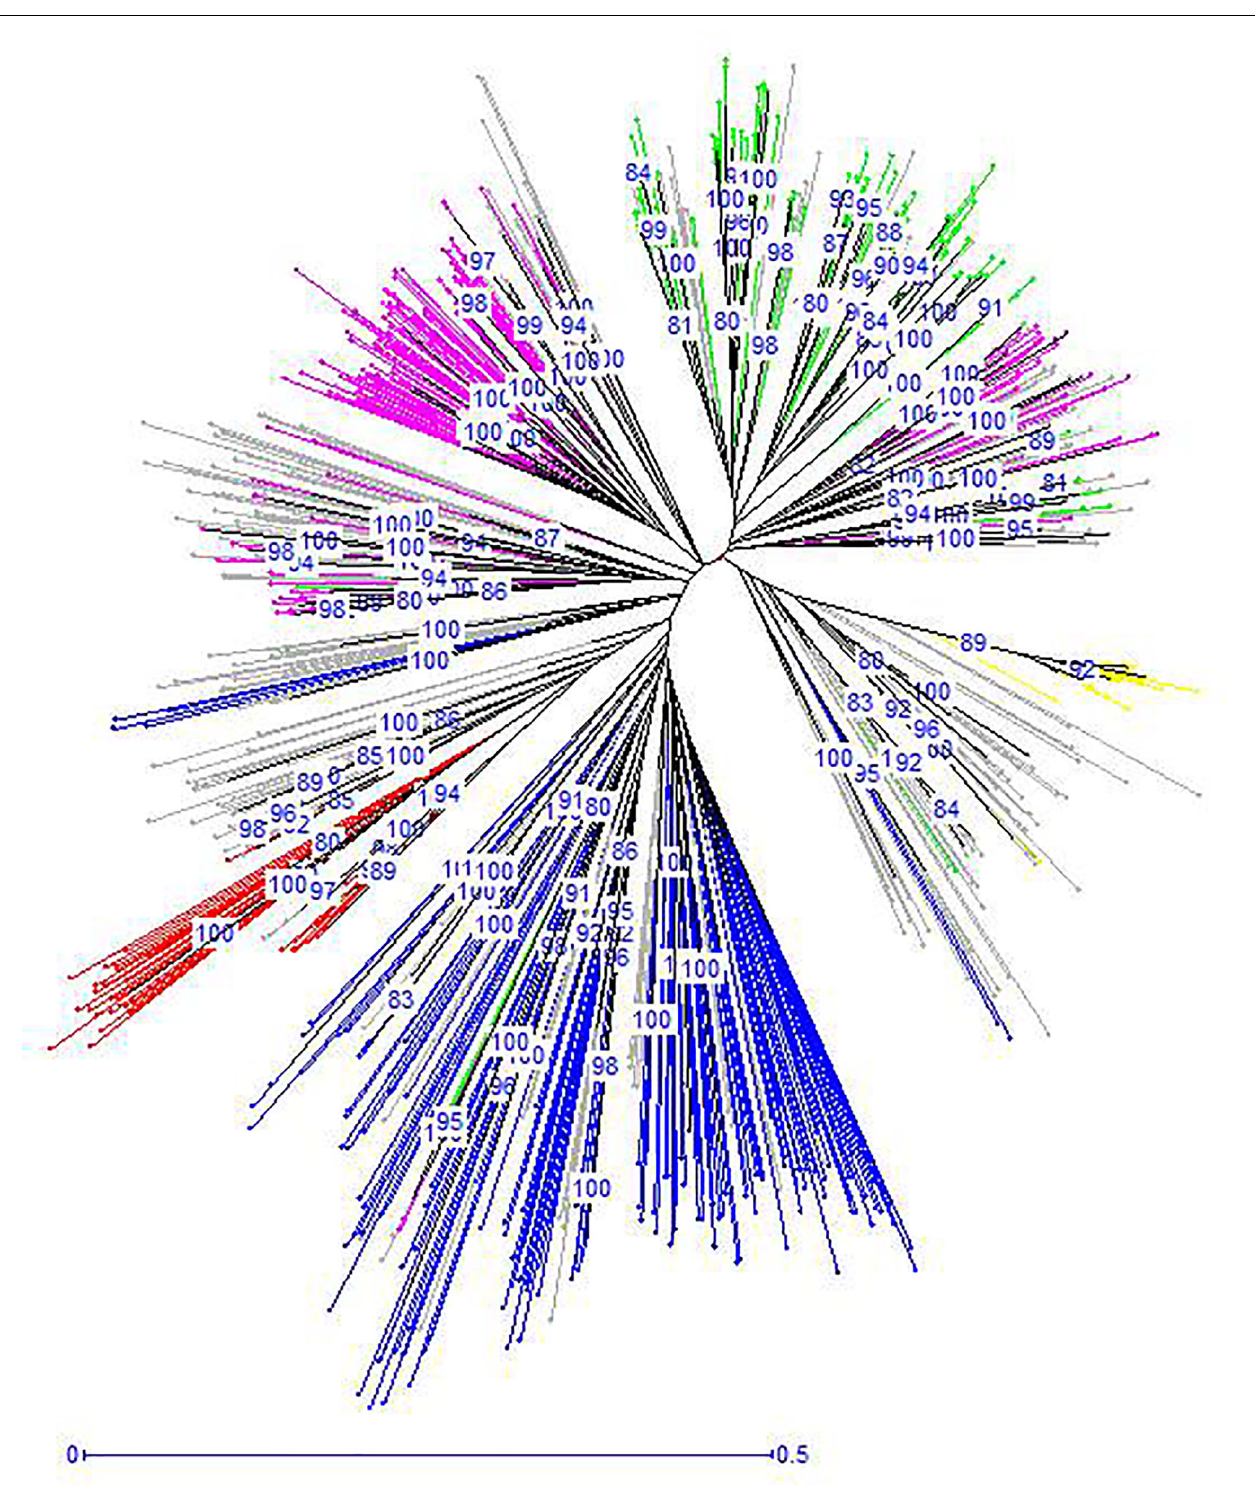
FIGURE 2 | Neighbor-joining dendrogram based on simple matching dissimilarity matrix showing relationships among the 890 apricot accessions. The five clusters identified by STRUCTURE analysis are depicted using the color codes as defined in Figure 1 with Cluster 1 in red, Cluster 2 in blue, Cluster 3 in pink, Cluster 4 in yellow, and Cluster 5 in green. The mixed accessions are in gray. Bootstrap values above 80% are shown.